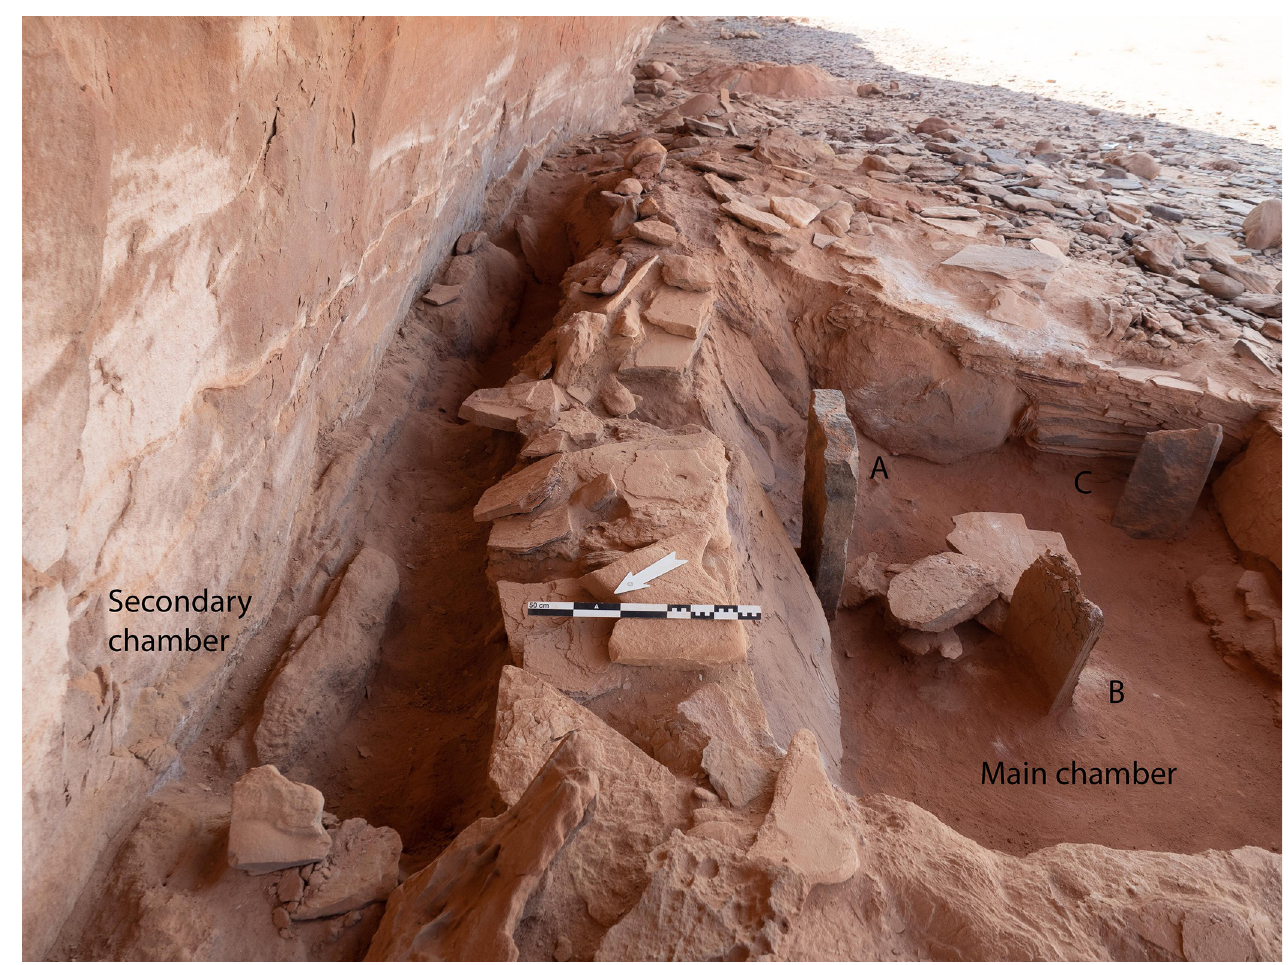
Fig 15. Spatial relationships between the main and secondary